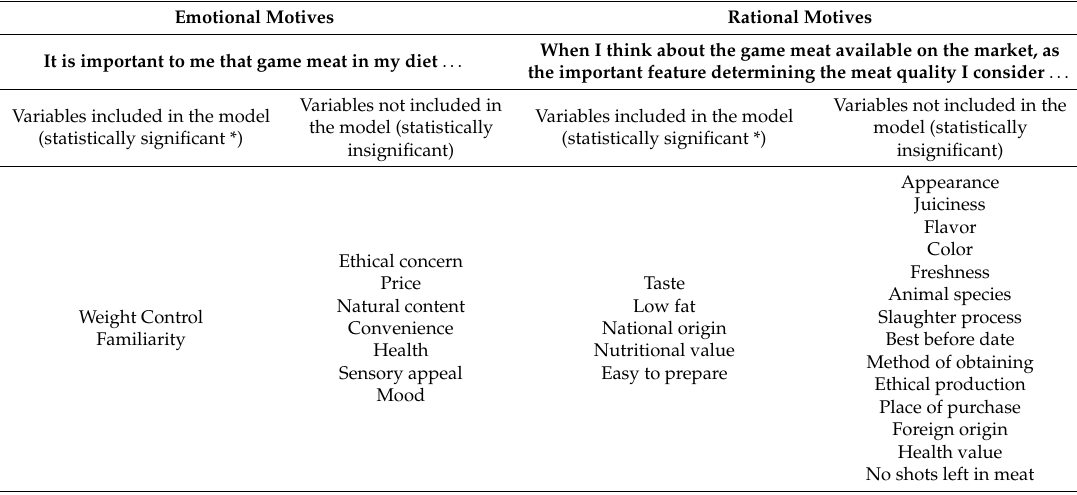
Table 4. Independent variables included in the statistical analysis. Emotional